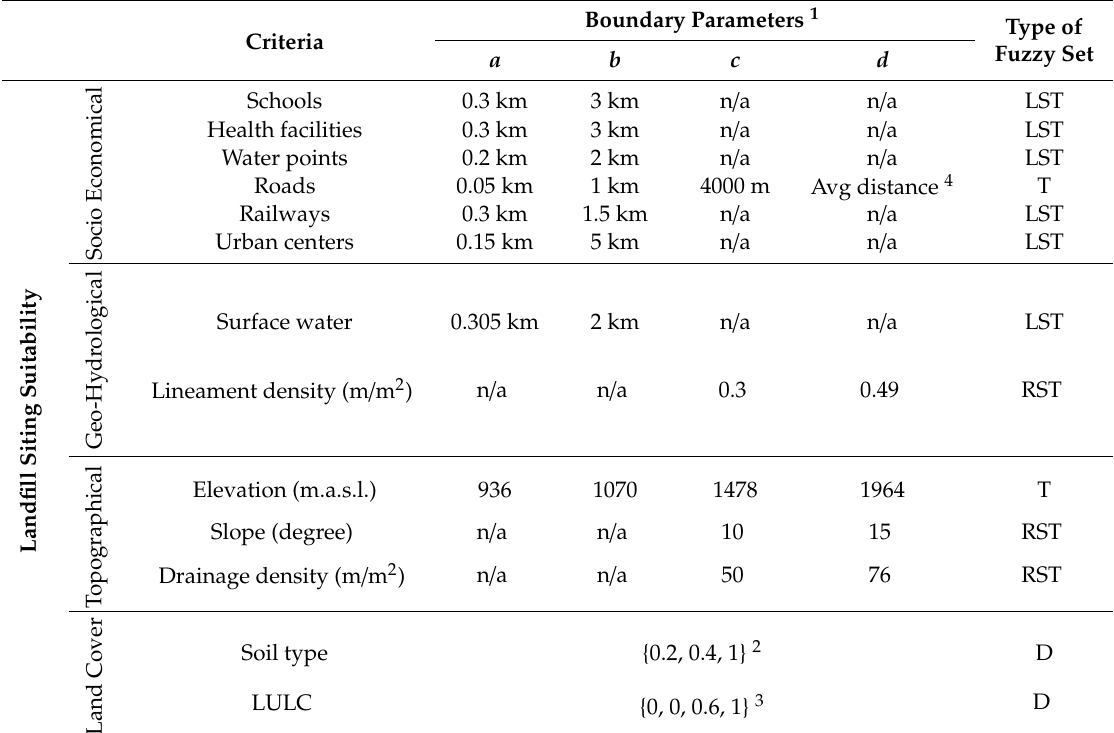
Table 2. Suggested membership function for landfill decision criteria.